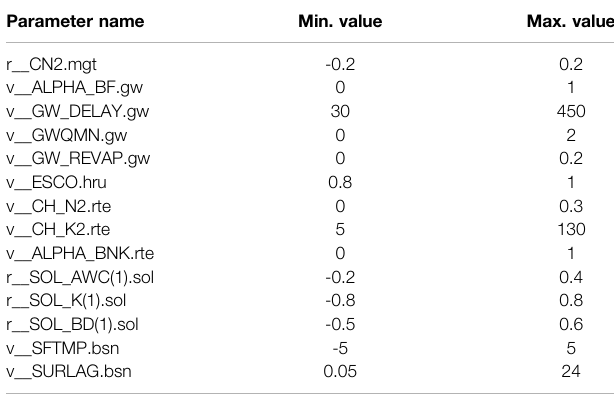
TABLE 1 | Input calibration parameters. TABLE 2 | SWAT CUP summary